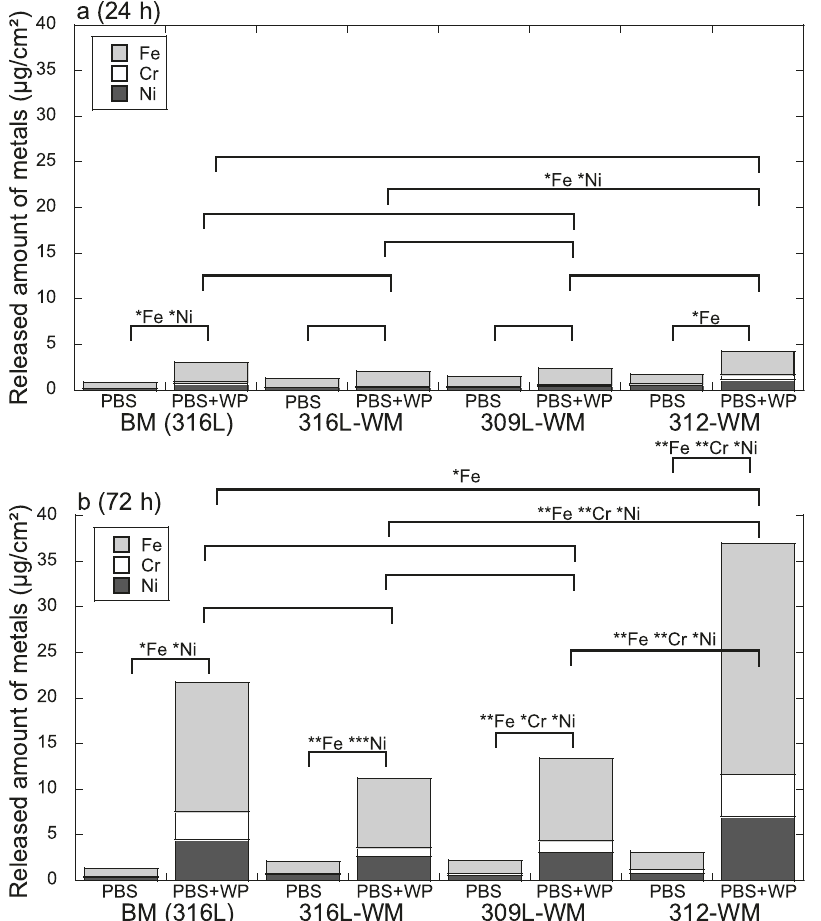
Fig. 7 Metal release under stirring conditions. Released average amounts of Fe, Cr, and Ni from the BM, 316L-WM, 309L-WM, and 312-WM triplicate coupons into PBS (adjusted to pH 6.8) and PBS with 10 g L -1 WP (PBS + WP) after 24 h ( a ) and 72 h ( b ) under stirring conditions with a magnetic stir bar at room temperature. Any signi fi cant difference between the solutions and between the different materials in PBS + WP are indicated by asterisks: * p < 0.05; ** p < 0.01; *** p < 0.001, for the respective elements. For details on the elemental release, see Supplementary Fig. 3.